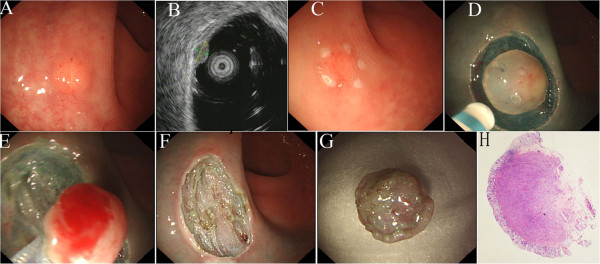
Endoscopic mucosal resection with circumferential incision of a rectal carcinoid tumour. (A) Conventional endoscopic view showing a carcinoid tumour in the rectum; (B) Endoscopic ultrasonography (EUS) image showing the lesion not to invade the muscularis propria layer; (C) Marking dots made around the lesion; (D) Circumferential incision around the dots; (E) Snaring after circumferential incision; (F) Region after endoscopic mucosal resection with circumferential incision; (G) Resected specimen; (H) Histologic view of a rectal carcinoid tumor obtained by endoscopic submucosal dissection (ESD) (H&E stain; ×40).